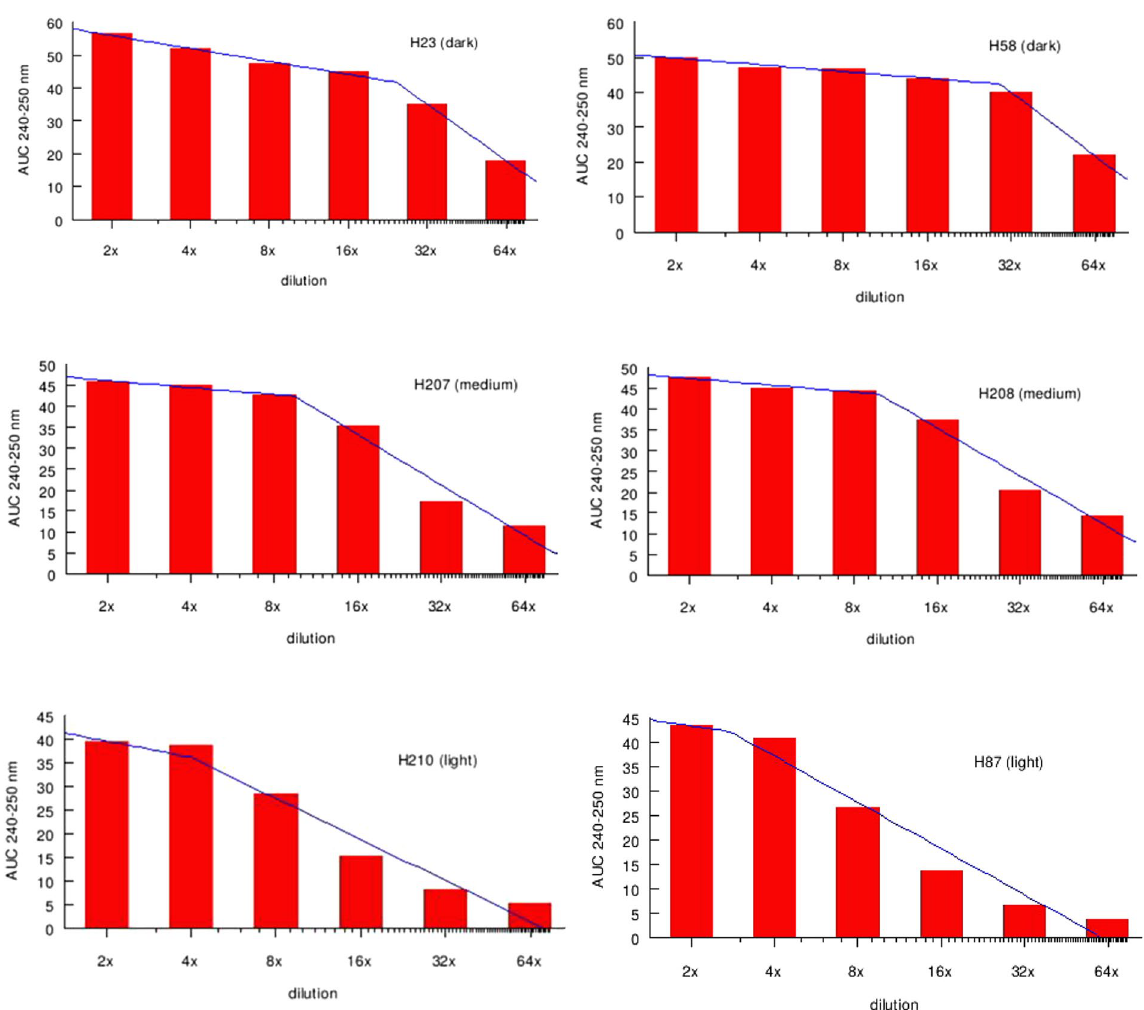
Figure 6. Typical fit for dark, medium and light honey to predict a phase transition